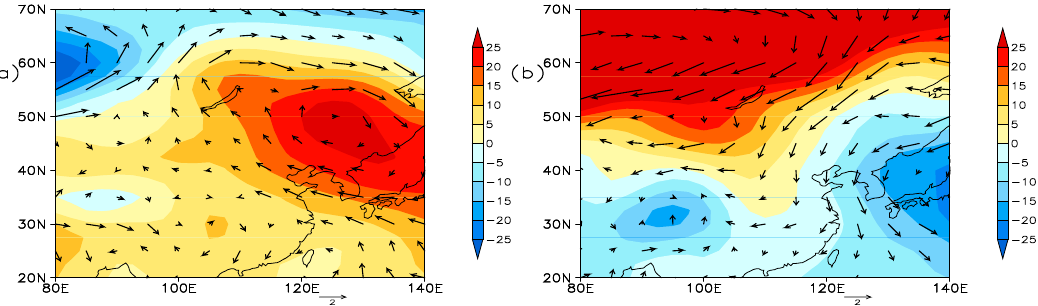
Figure 9. Compound field of the January geopotential height anomaly (shading, units: gpm) and wind (vector, units:m/s) of 850 hPa in January of the higher haze-fog years ( a ) and lower haze-fog years ( b